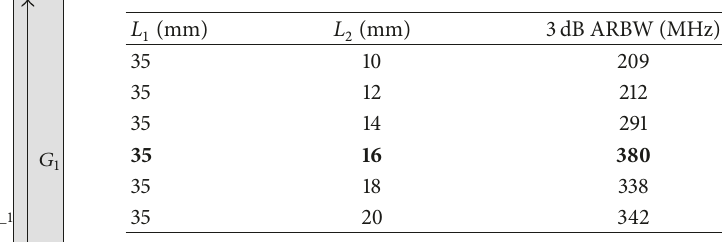
Table 1: Detailed results of the proposed antenna for various T- shaped microstrip line